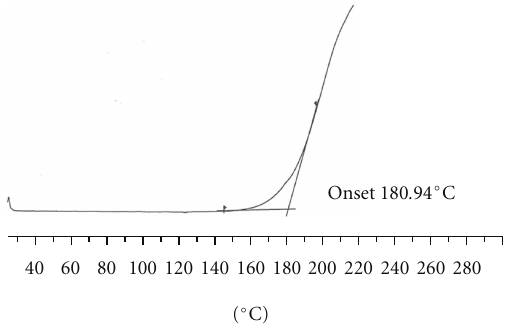
Figure 7: Di ff erential scanning calorimetry oxidation stability curve of HYOOA.